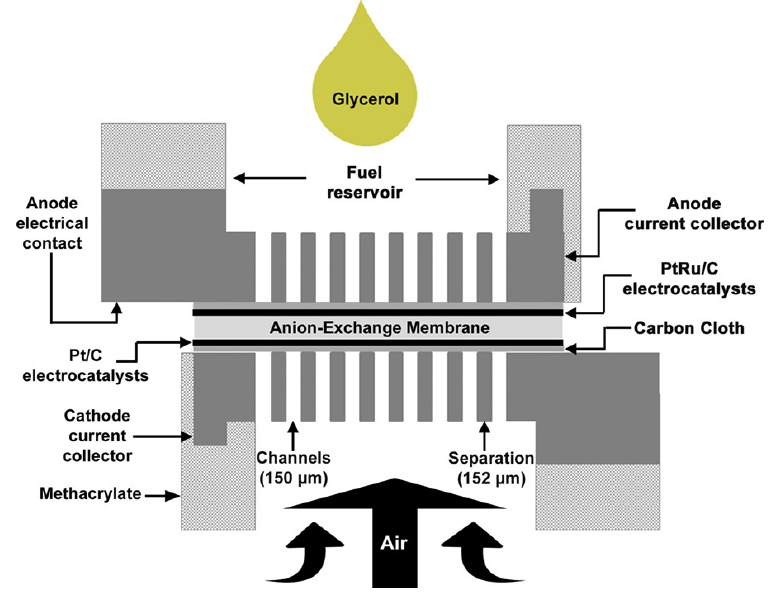
Figure 17. Schematic drawing showing the cross-section of the assembled AEM-based PS-DGlyFC. Reproduced from [169] with permission from John Wiley and Sons 2019.